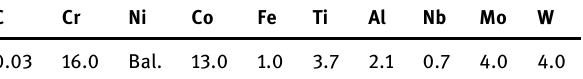
Table 1: Nominal composition of René 65 ( % ) [ 8 – 16 ]